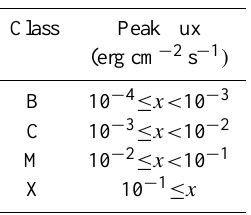
Table 2. Solar flare classification scheme according to the Peak flux in X-rays.